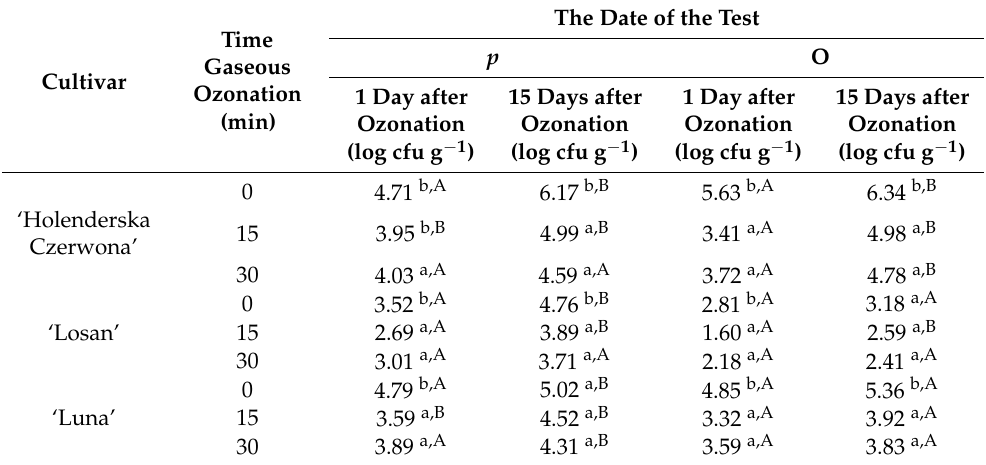
15 Days after Ozonation (log cfu g − 1 )